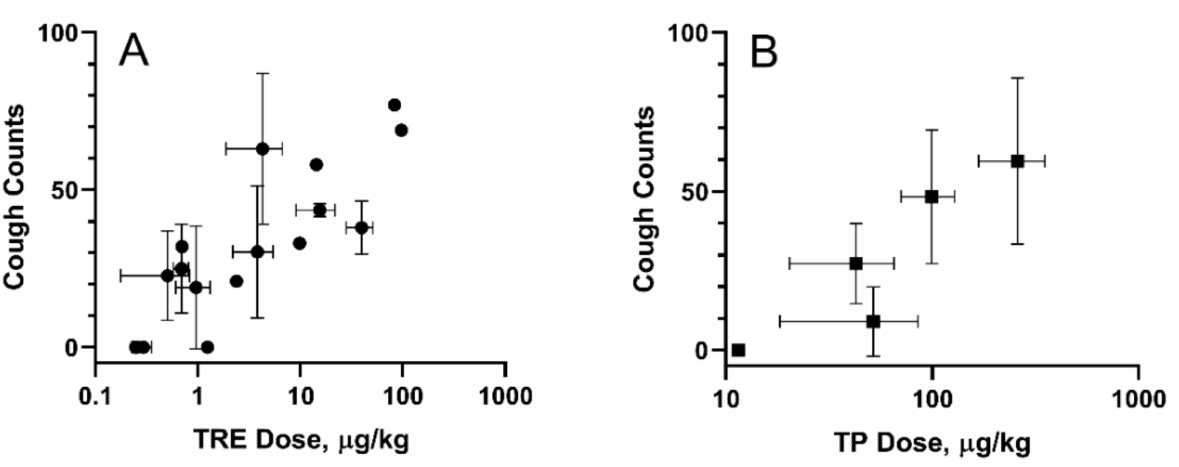
Figure 6. Cough in guinea pigs induced by exposure to inhaled TRE-MDI ( A ) and TPIA ( B ). Error bars represent standard deviation; each point represents data collected from a single experiment day.